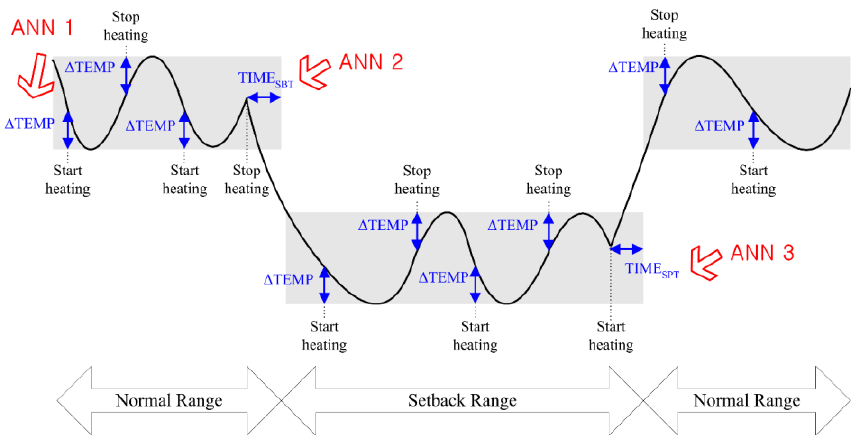
Figure 6. A conceptual temperature profile with the predictive control algorithm.